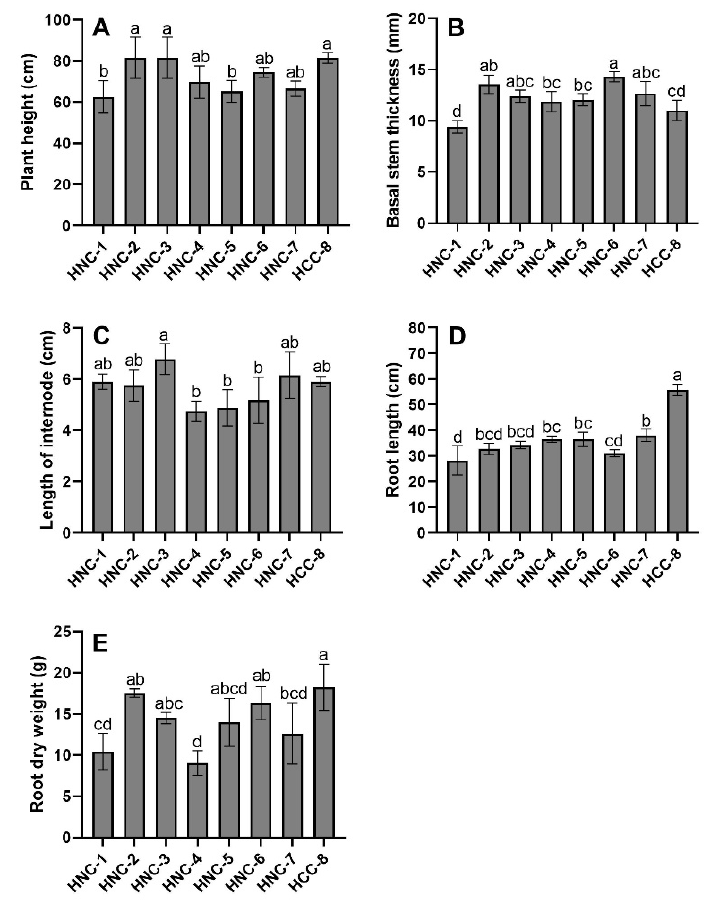
Figure 2. Plant height ( A ), basal stem thickness ( B ), internode length ( C ), root length ( D ), and root dry weight ( E ) of eight genotypes of habanero pepper grown in the southeast of Coahuila. Values are the average of four replications. Means ( n = 4). Bars represent the standard deviation of the mean. Different letters in each bar mean that the genotypes were statistically different (Tukey, p ≤ 0.05).